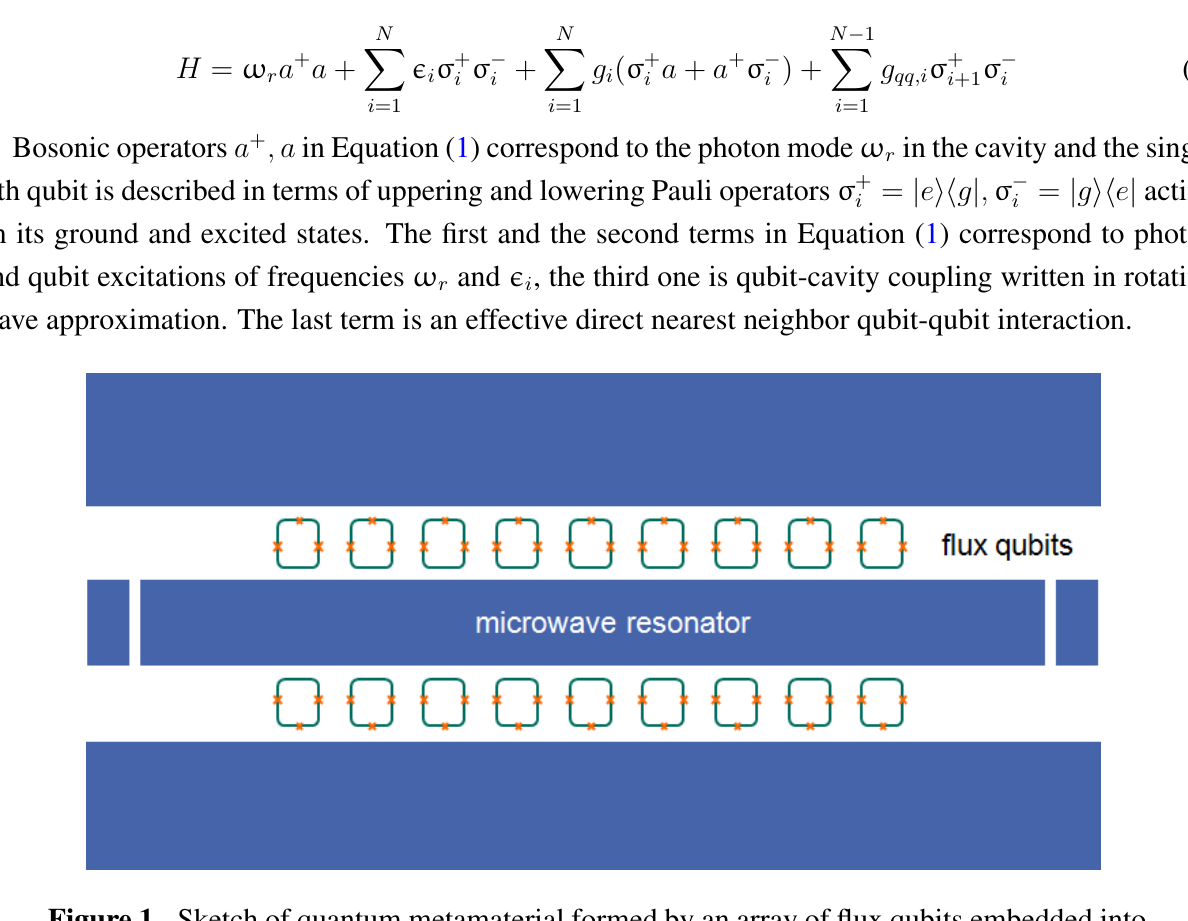
Figure 1. Sketch of quantum metamaterial formed by an array of flux qubits embedded into a microwave